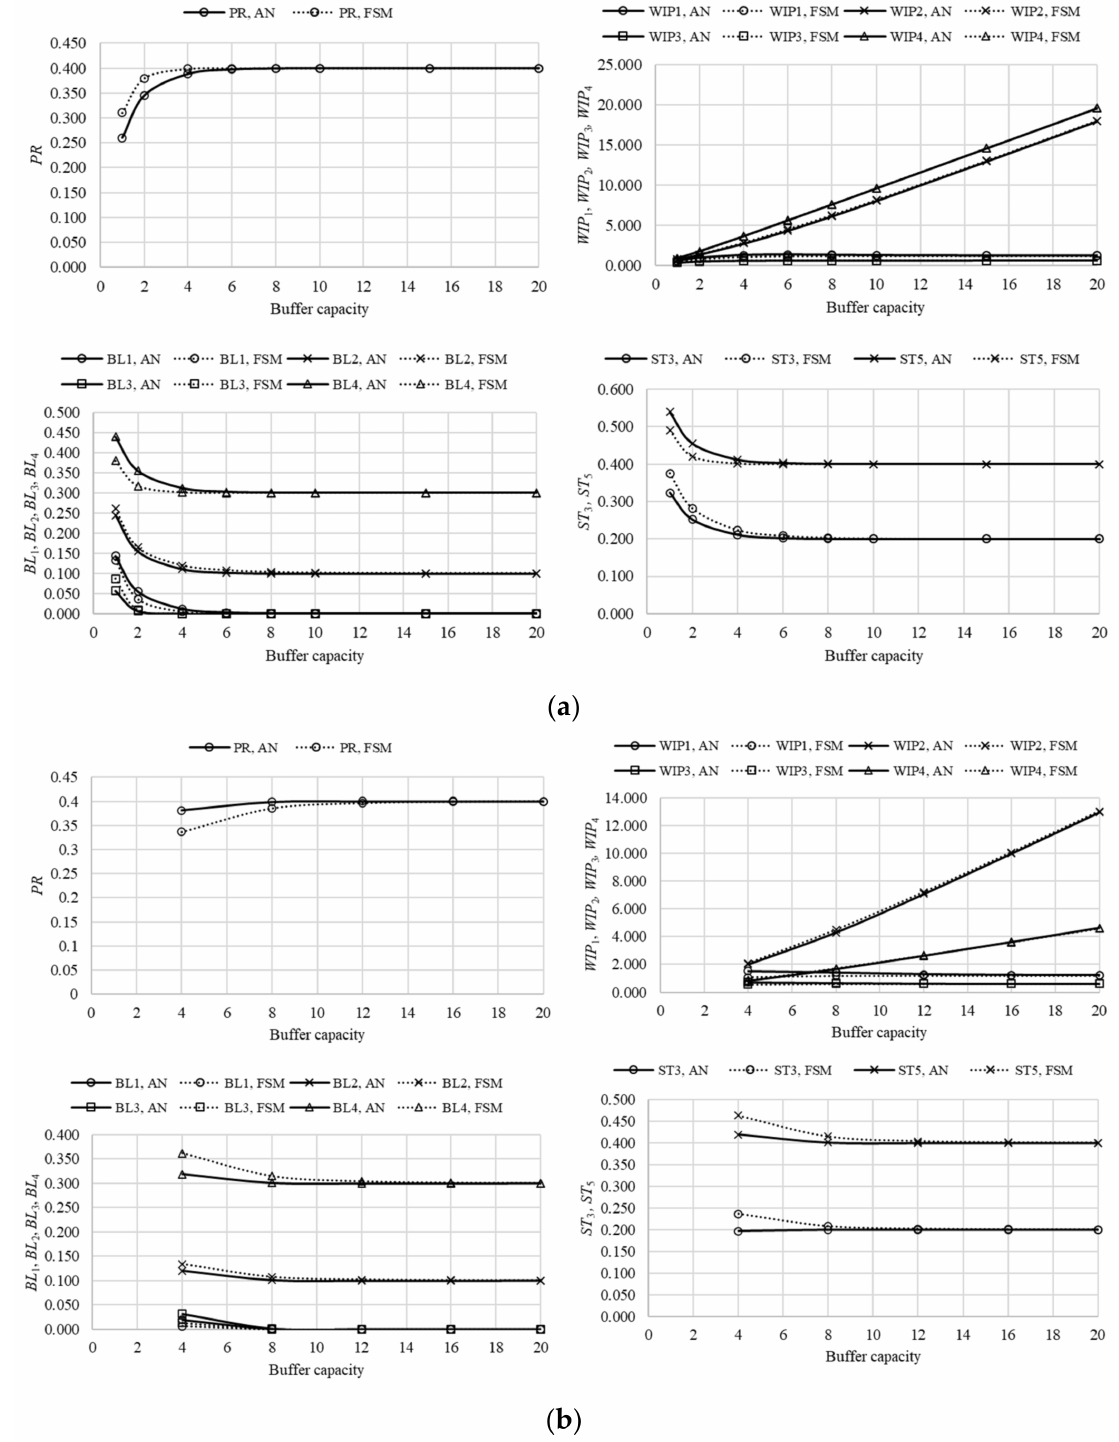
Figure 13. Comparison of the performance measures in the case of line L5E: ( a ) N 1 = N 2 = N 3 = N 4 = N ; ( b ) N 1 = N , N 2 = 3 / 4 N , N 3 = 1 / 2 N , N 4 = 1 / 4 N